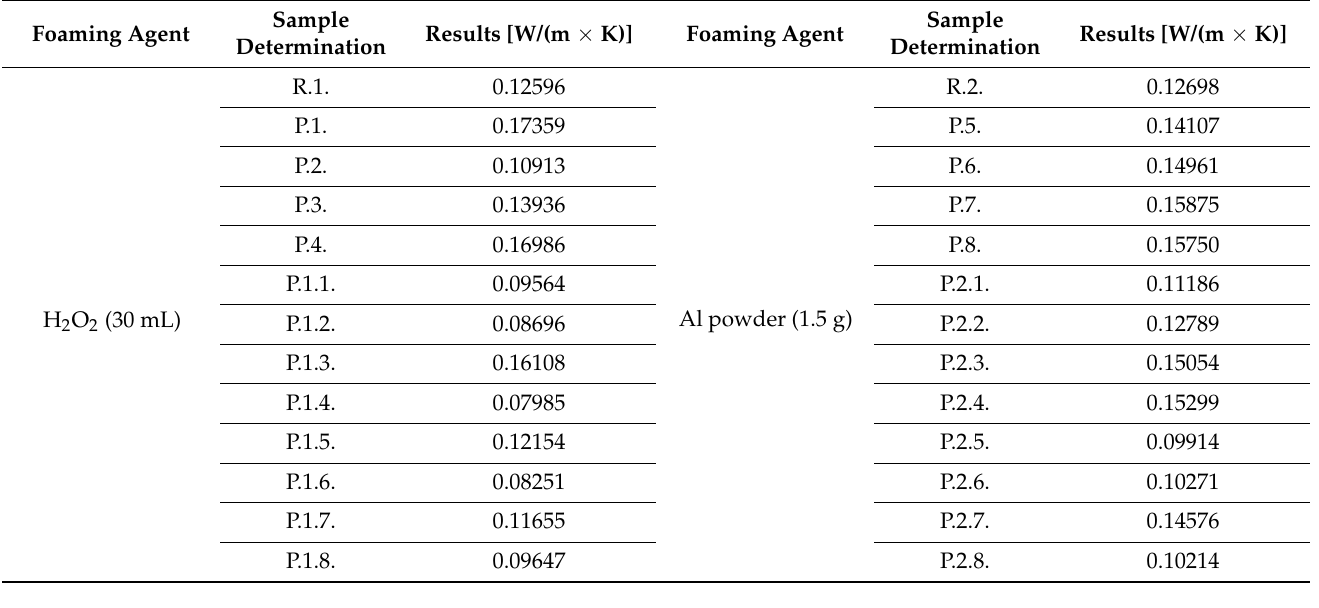
Table 5. Coefficient of thermal conductivity for samples with H 2 O 2 and aluminum.